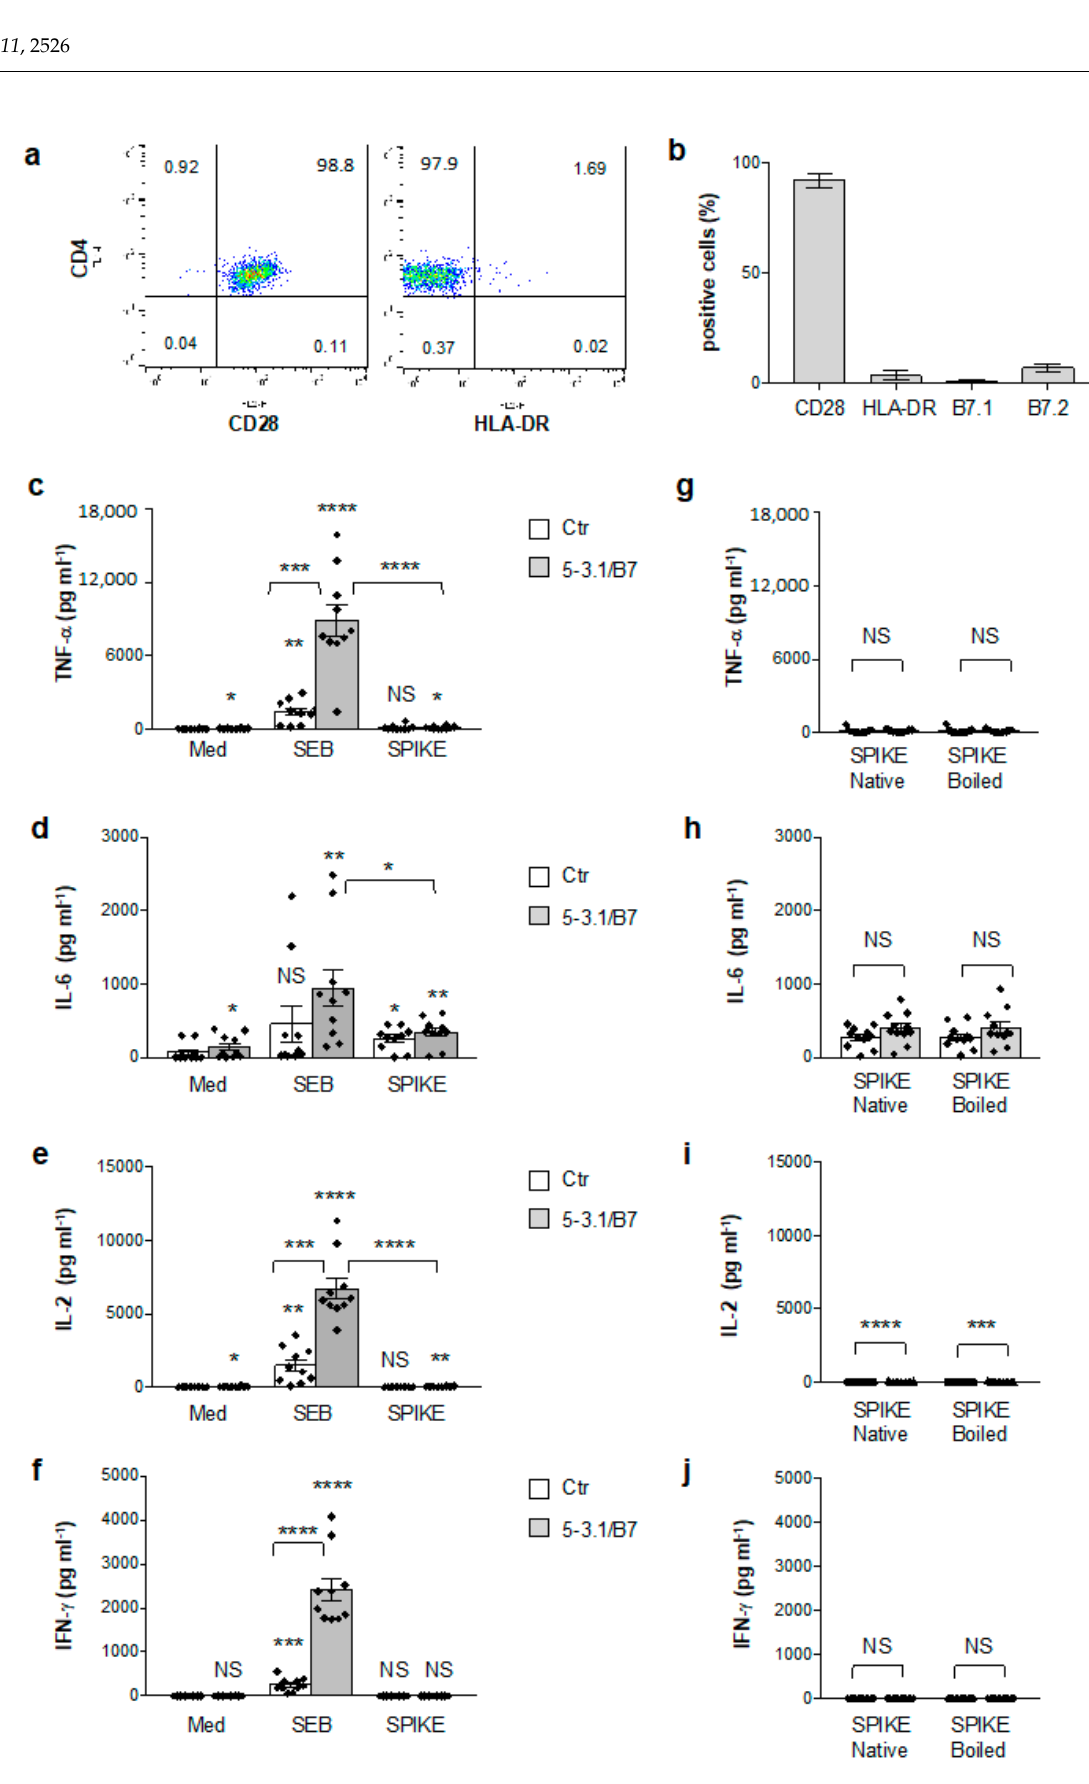
Figure 2. SARS-CoV-2 spike does not stimulate inflammatory cytokine production in peripheral blood CD4 + T cells. ( a ) Representative FACS analysis of human CD4 + T cells isolated from the